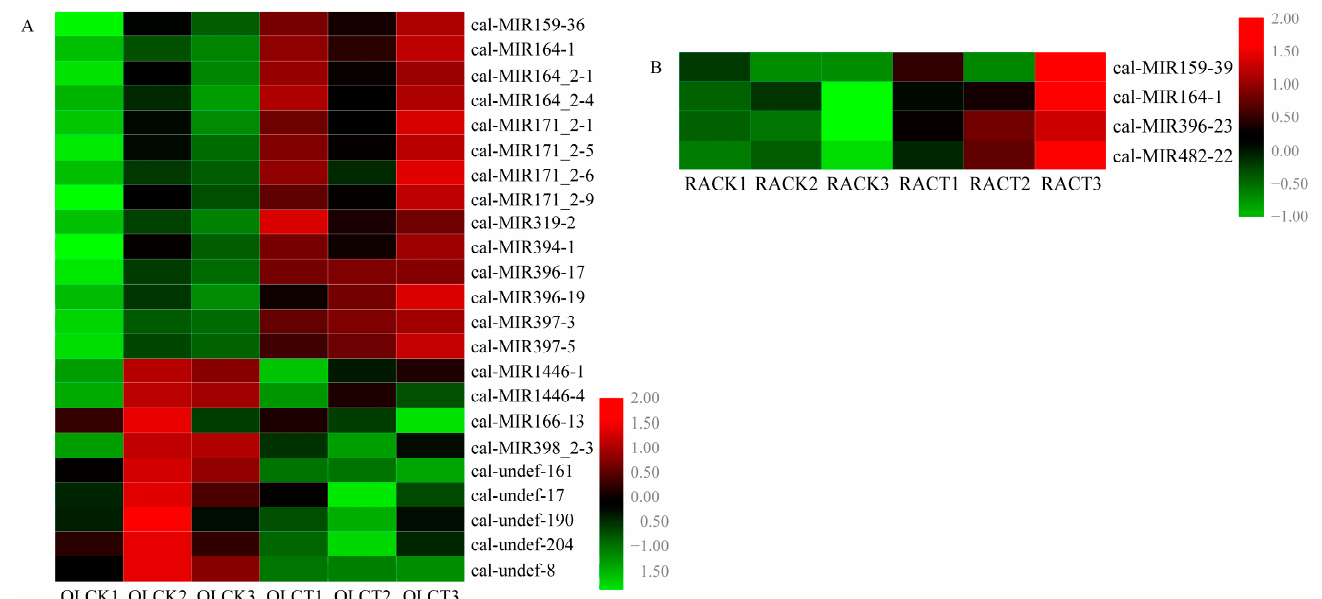
Figure 3. Heat maps for the identified LTS-responsive DEMs in QL ( A ) and RA ( B ). Each column represents a given sample and each row indicates the relative expression of the differentially expressed miRNAs.